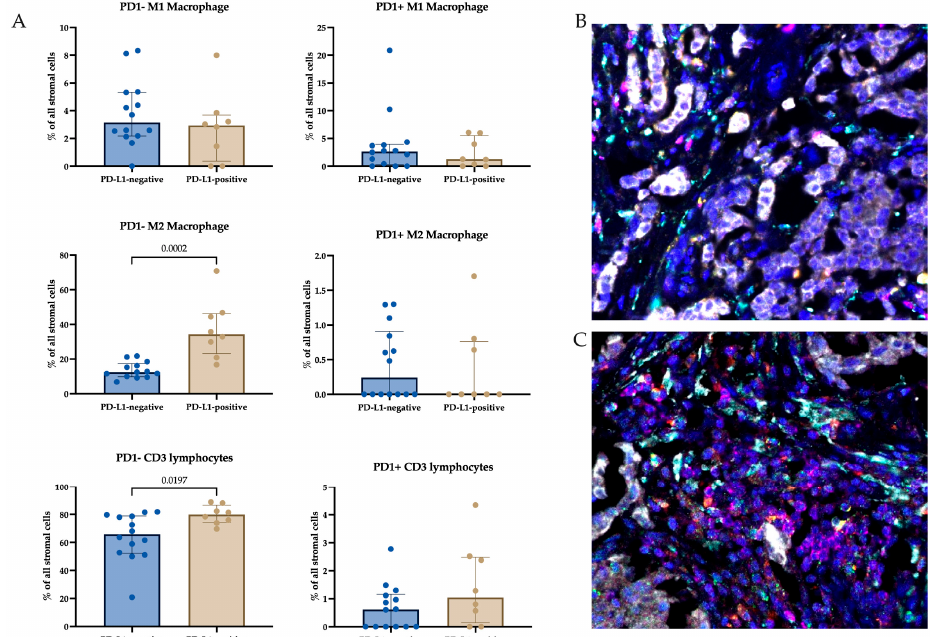
Figure 4. Percentage ( A ) of PD1-negative and PD1-positive M1 and M2 macrophages and T lymphocytes in PD-L1-negative ( B ) and PD-L1-positive ( C ) tumors. M1 (yellow) and M2 (cyan) macrophages and T lymphocytes (purple) were examined using multiplex immunohistochemistry. Magnification 630×.